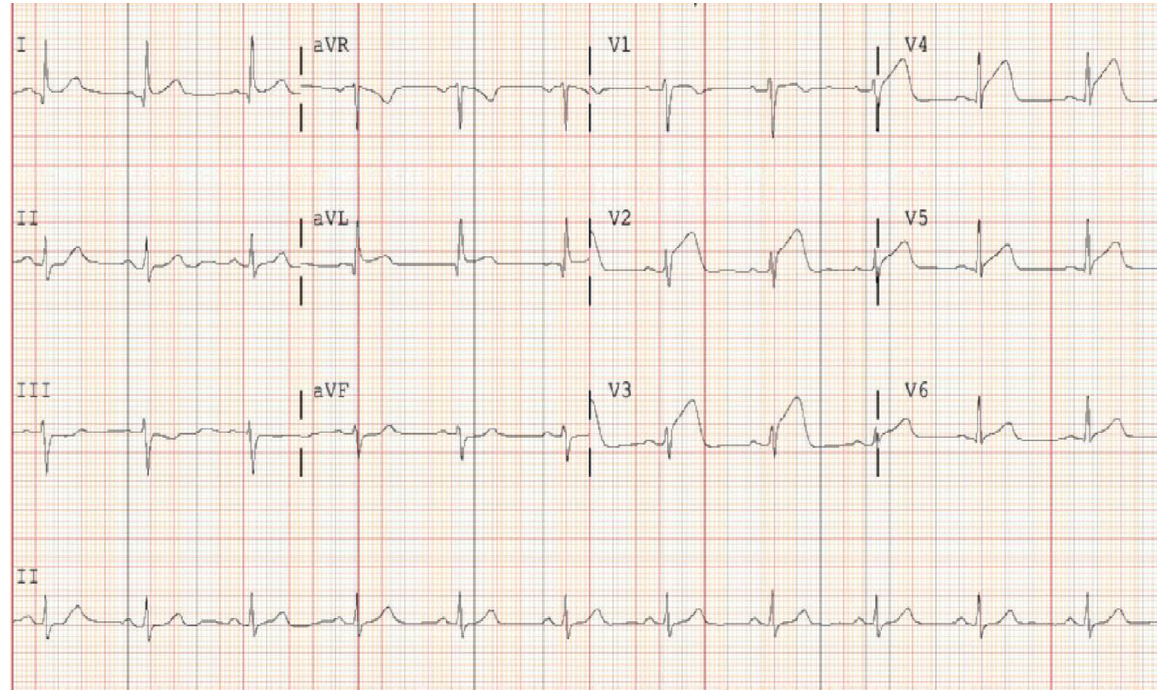
Figure 1: Patient ’ s initial ECG showing ST-segment elevation in V2-V5, consistent with anterior